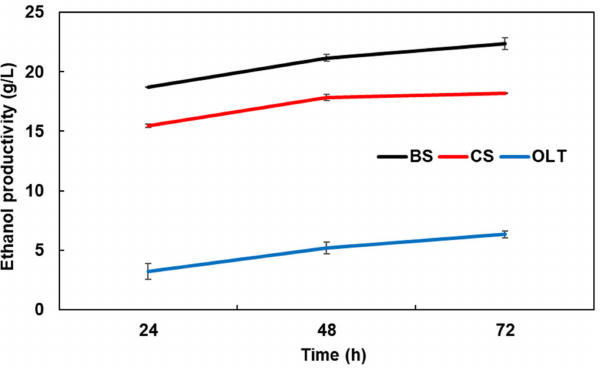
Figure 1. Ethanol production profile (g/L) of the selected yeast P. kudriavzevii YSR7 during SSF at 42 ◦ C of alkali- treated BS, CS, and OTP biomasses.